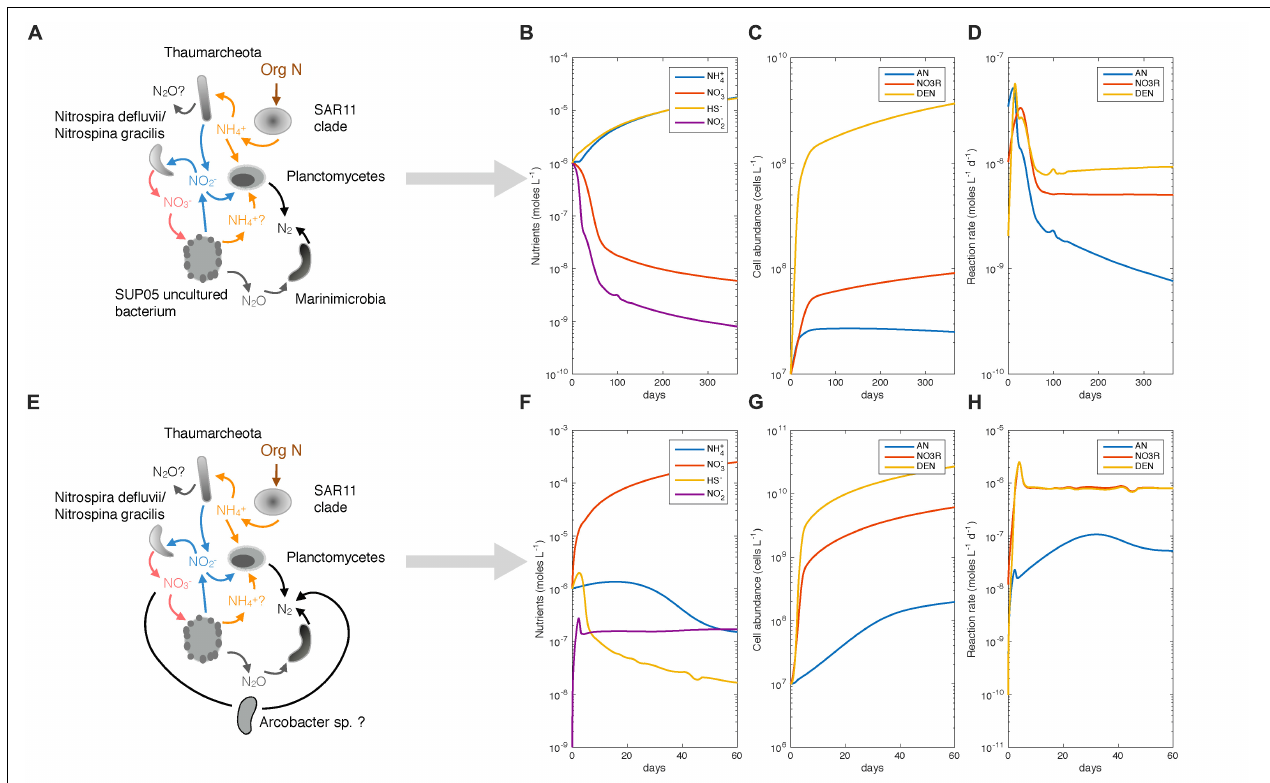
FIGURE 12 | Model of NO 2 − competition between anammox and complete denitrification for the 2 ecotypes found in SI, “stagnation phenotype” and “renewal phenotype”. (A) Represents the ecotype found in SI during stagnant periods of time. (B–D) Shows a simulation of the model that tested to see if the phenotype of the ecotype could be reproduced through modeling. Parameters used to model this simulation can be found in Table 3 . (E) Represents the second ecotype found in SI during renewal event, leading to higher N 2 production (F–H) shows that the model reproduced higher rates of N 2 production. Parameters used in this simulation can be found in Table 3